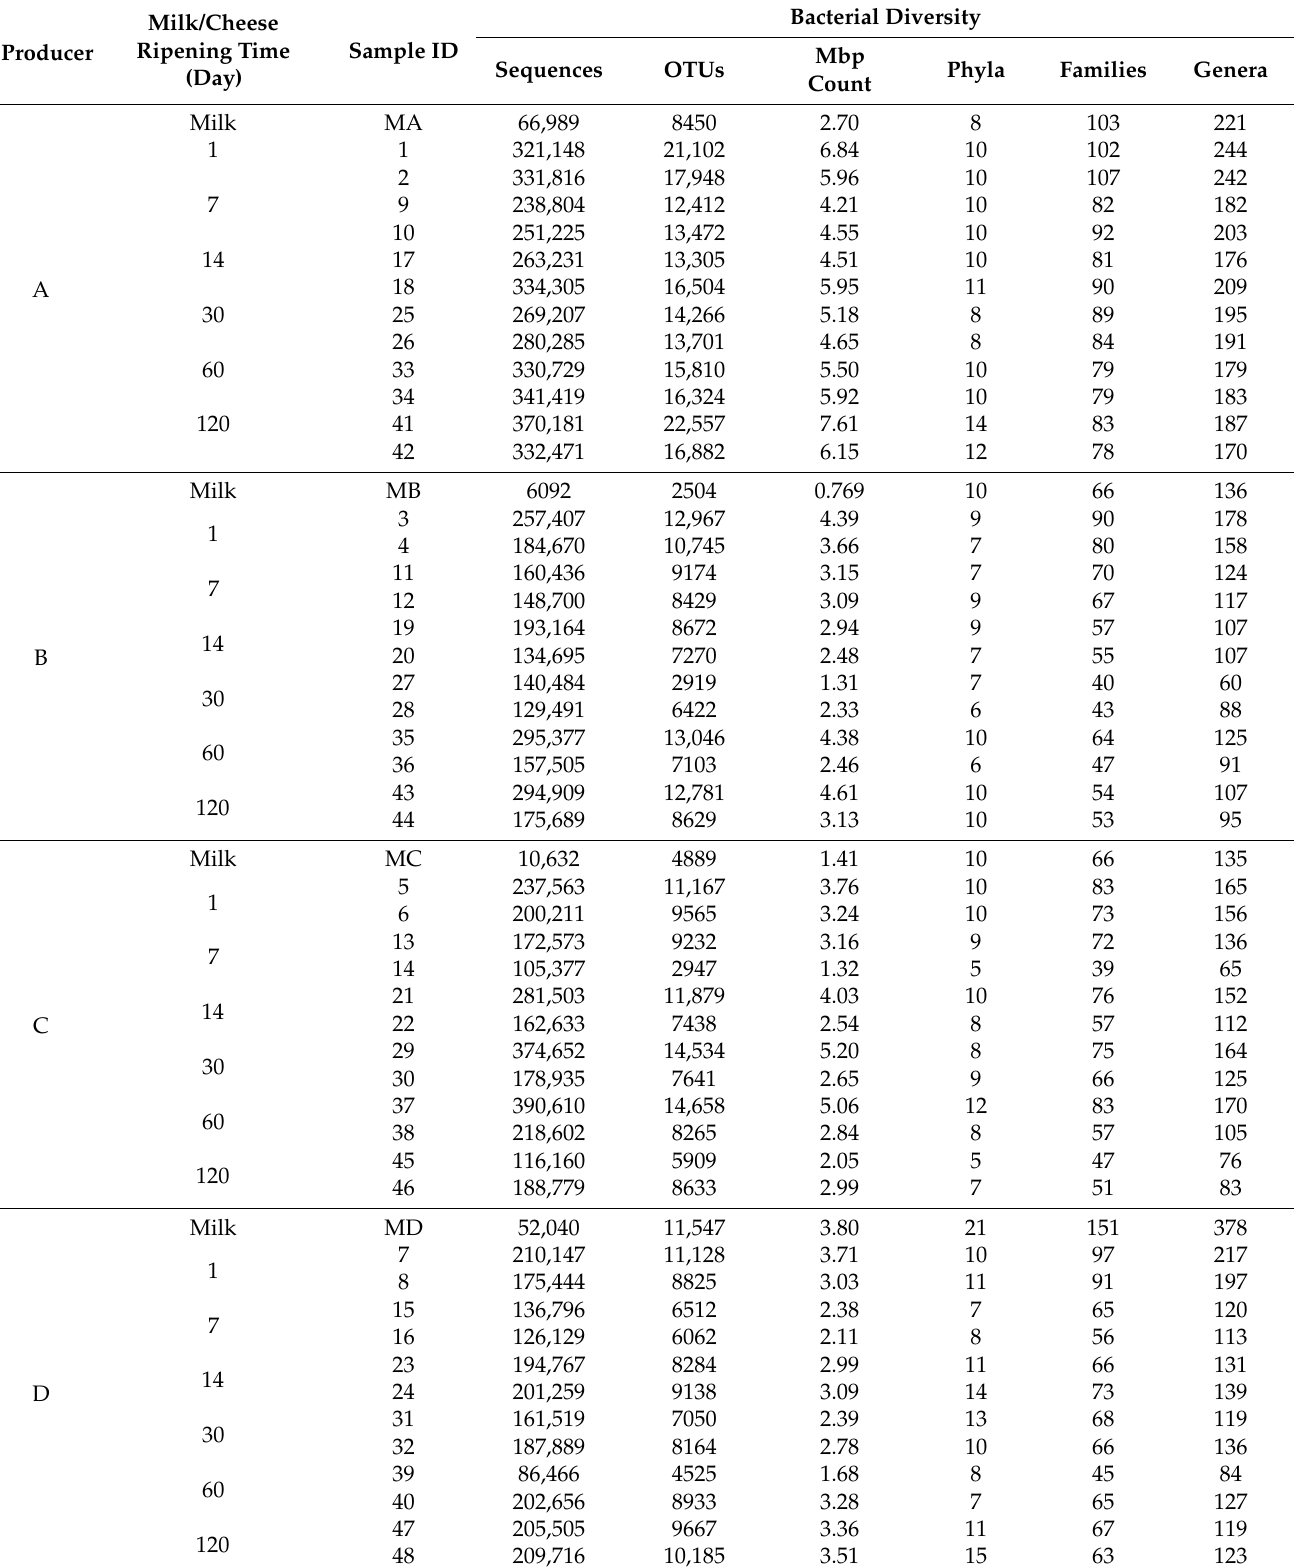
Table 1. Metataxonomic data of Latxa ewe raw milk and Idiazabal cheese samples at 6 ripening times (1, 7, 14, 30, 60 and 120 days) from 4 producers (A, B, C and D) ( n =